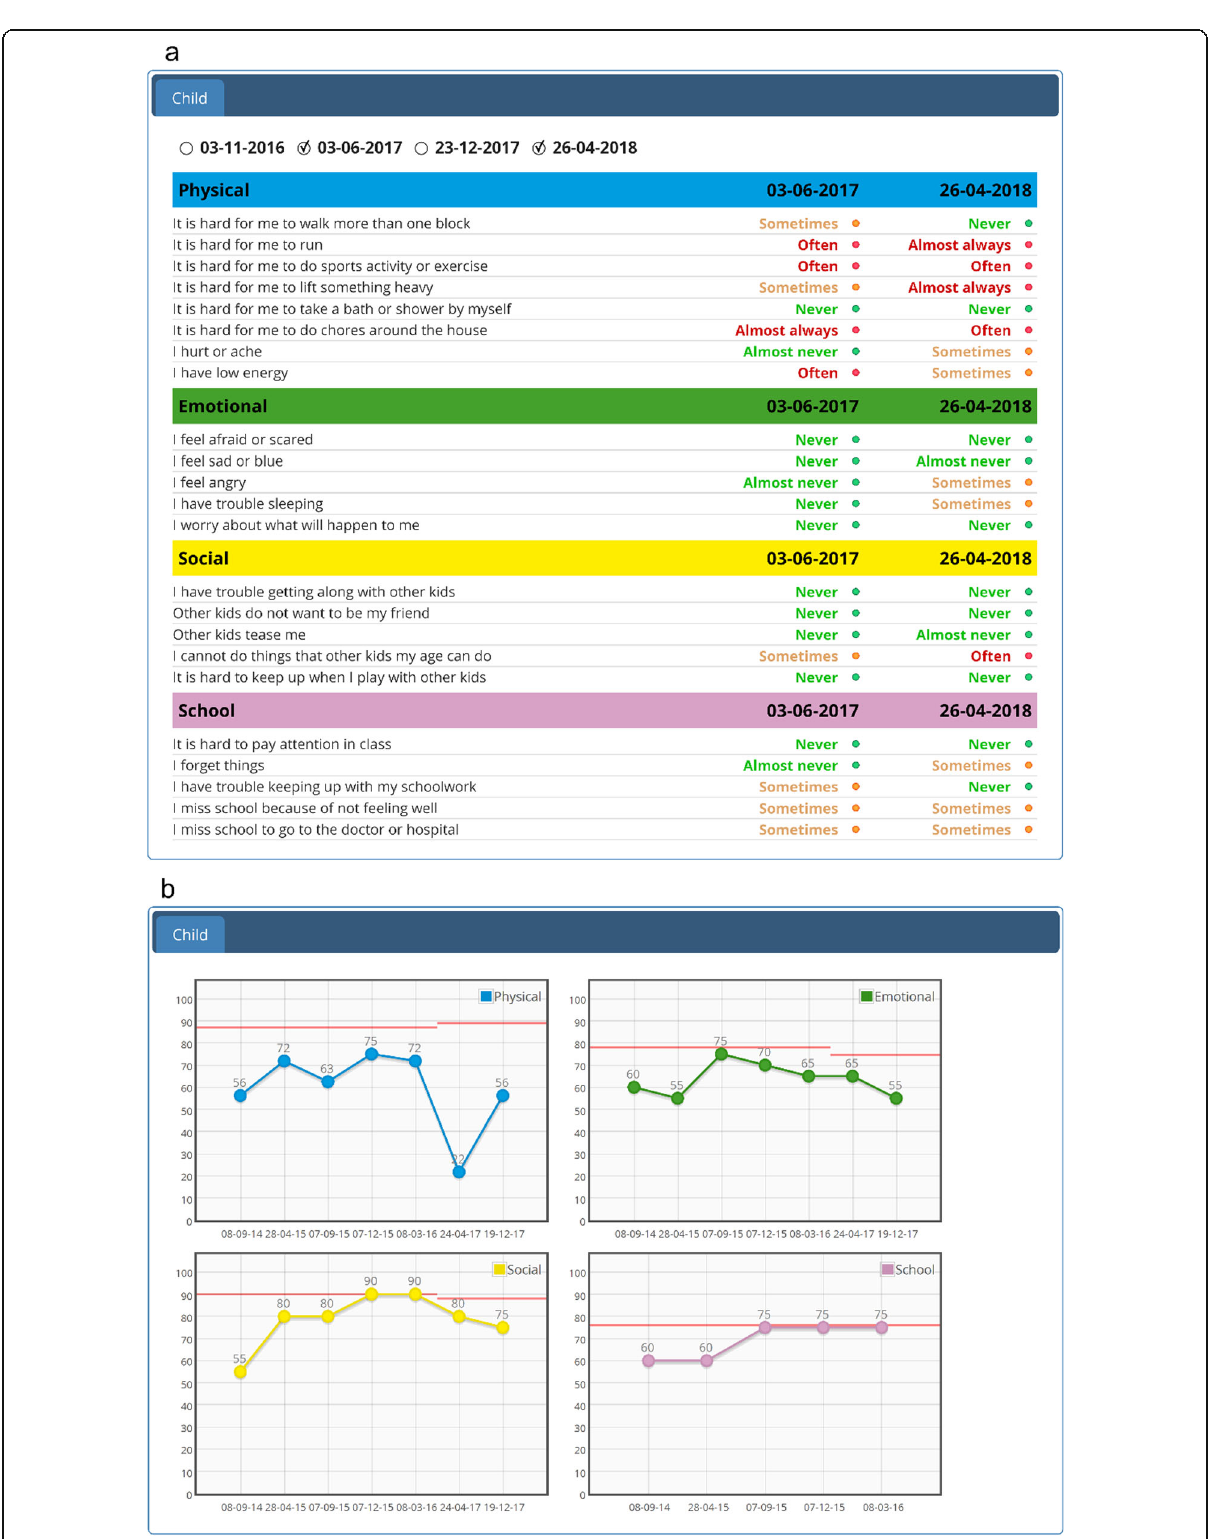
Fig. 1 Current PROM individual item ( 1a ) and domain score ( 1b ) feedback in the KLIK